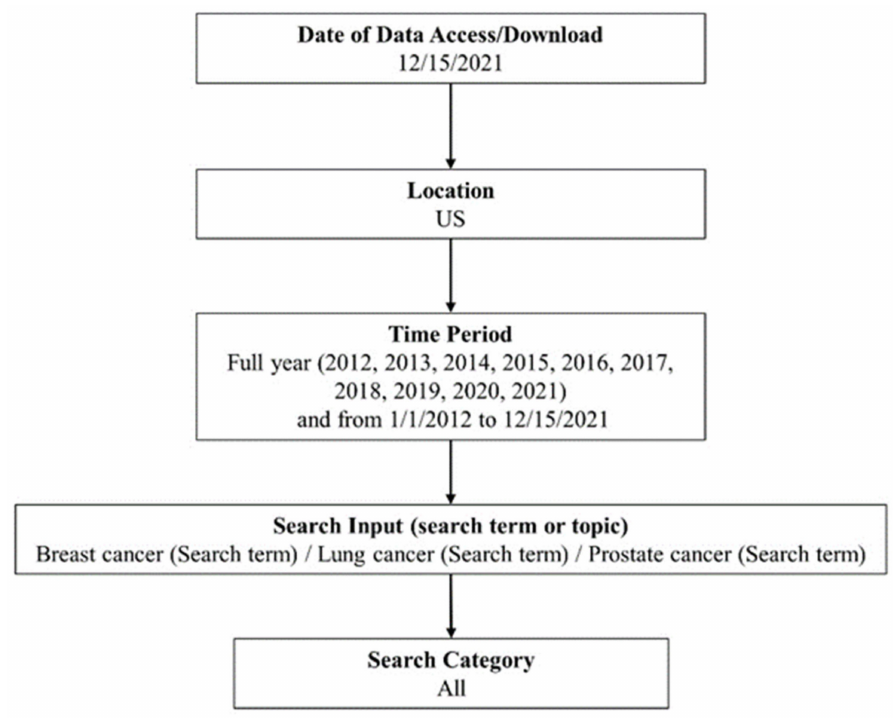
Figure 1. Google Trends search